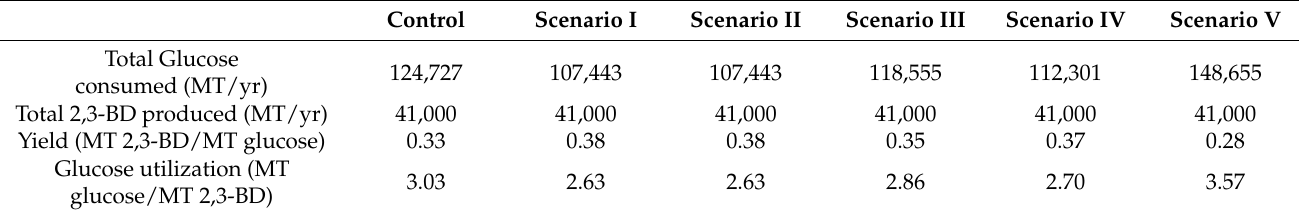
Table 11. Average glucose utilization per MT of 2,3-BD